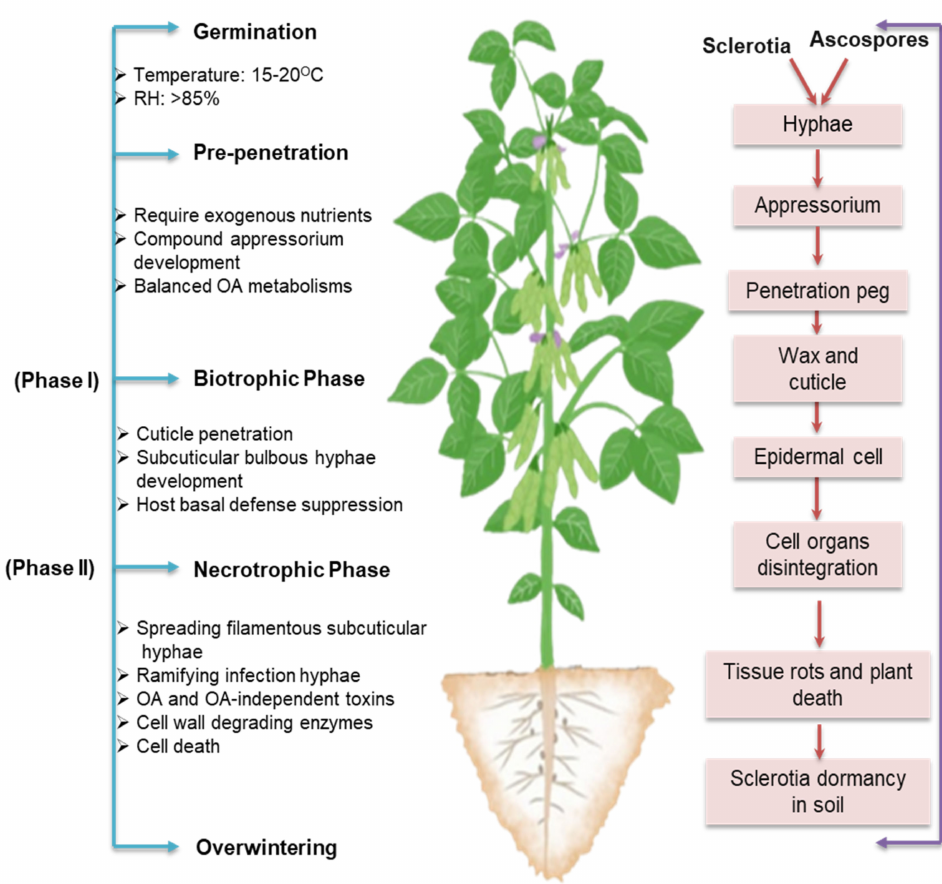
Figure 3. A two–phase infection model of Sclerotinia sclerotiorum presented schematically,